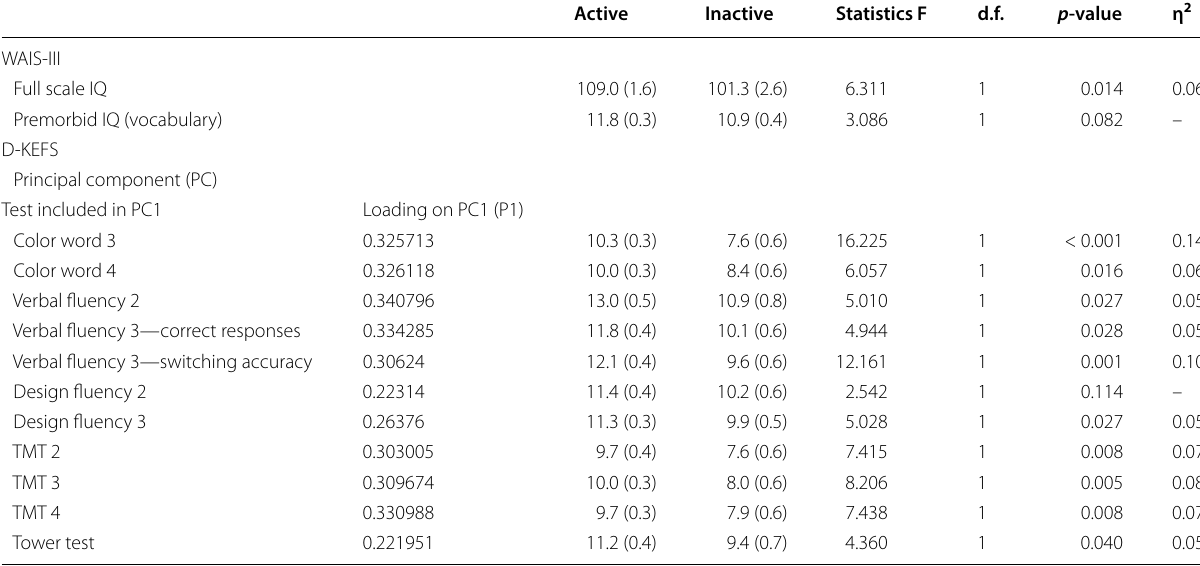
Table 2 Neurocognitive assessment for all participants